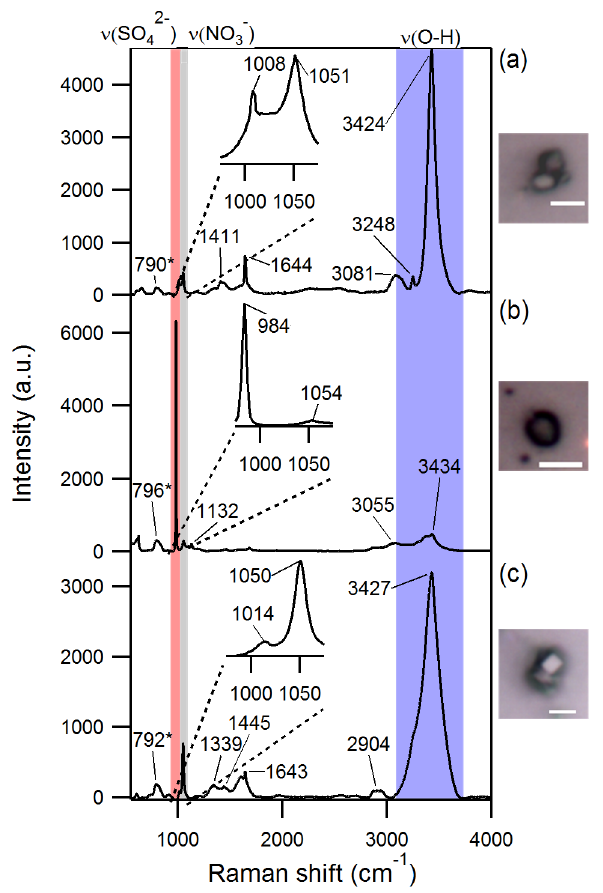
Figure 3. Optical images and Raman spectra of three representa- tive SSA particles containing nitrate and/or sulfate and hydroxyl groups. A total of ∼ 300 individual particles were analyzed by Ra- man microspectroscopy. * The 790–796cm − 1 peak is due to quartz substrate background. Scale bar for all images is